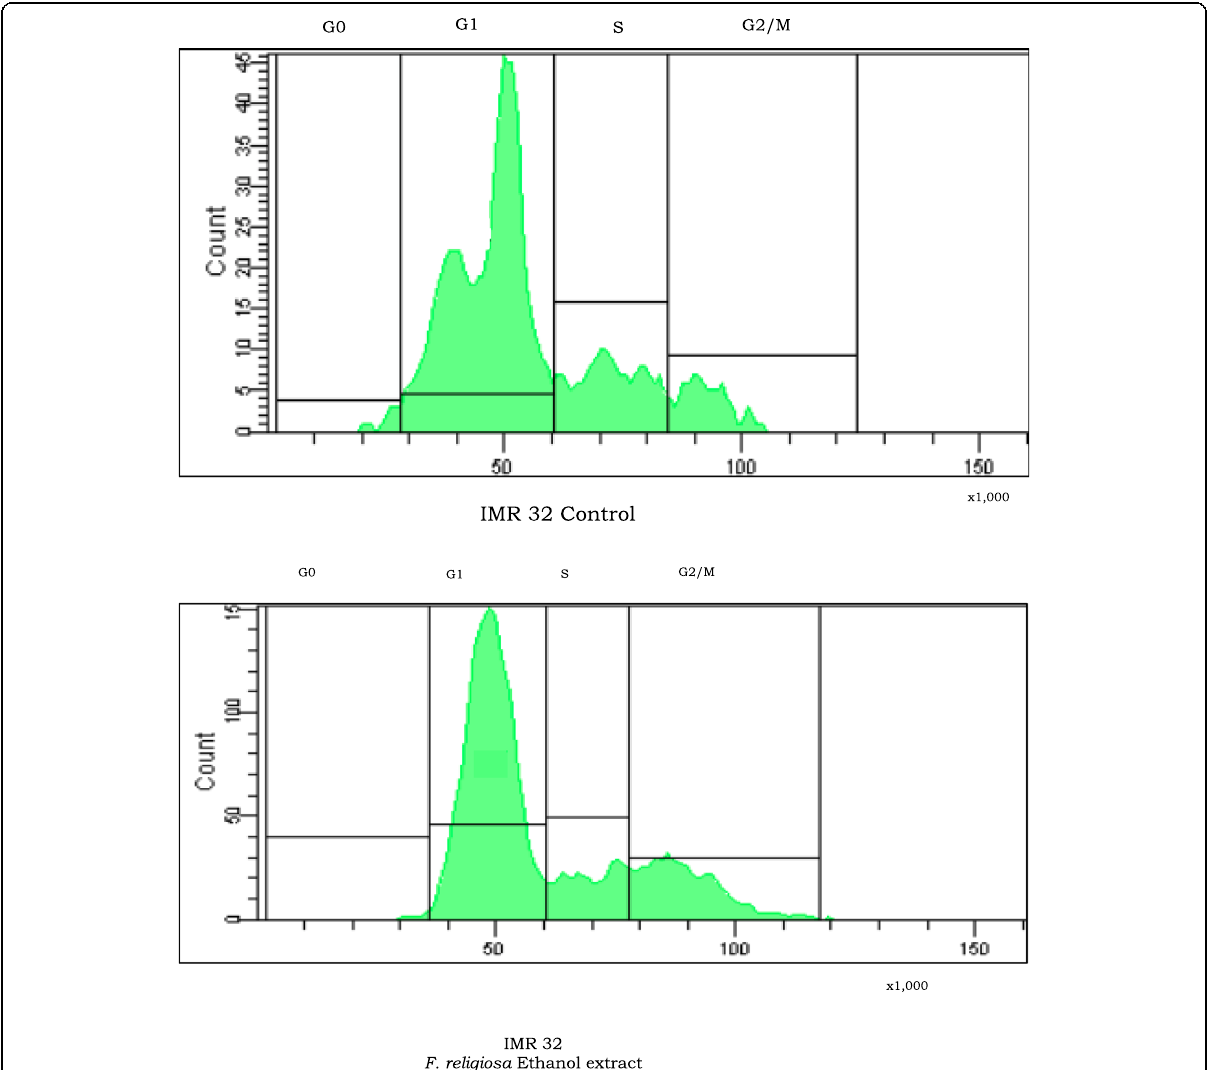
Fig. 17 Analysis of cell cycle arrest of IMR 32 cells when treated with IC 50 concentration of F. religiosa ethanolic extract (4.8 μ g/ml) and along with control IMR 32 cells